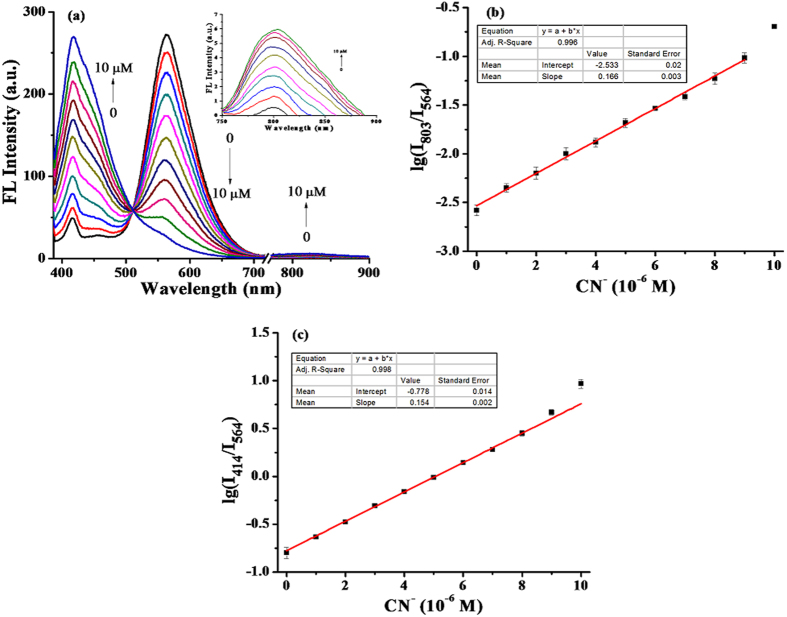
The fluorescence titration studies of SY towards CN−.(a) Fluorescence spectra of SY (5 μM) upon addition of CN− (0–10 μM) at room temperature. Inset: enlarged fluorescence spectra from 750 nm to 900 nm, λex = 360 nm. (b) The corresponding linear relationship between the logarithm of the fluorescence ratio (I803/I564) in the presence of CN− (0–9 μM). (c) The corresponding linear relationship between the logarithm of the fluorescence ratio (I414/I564) in the presence of CN− (0–10 μM).